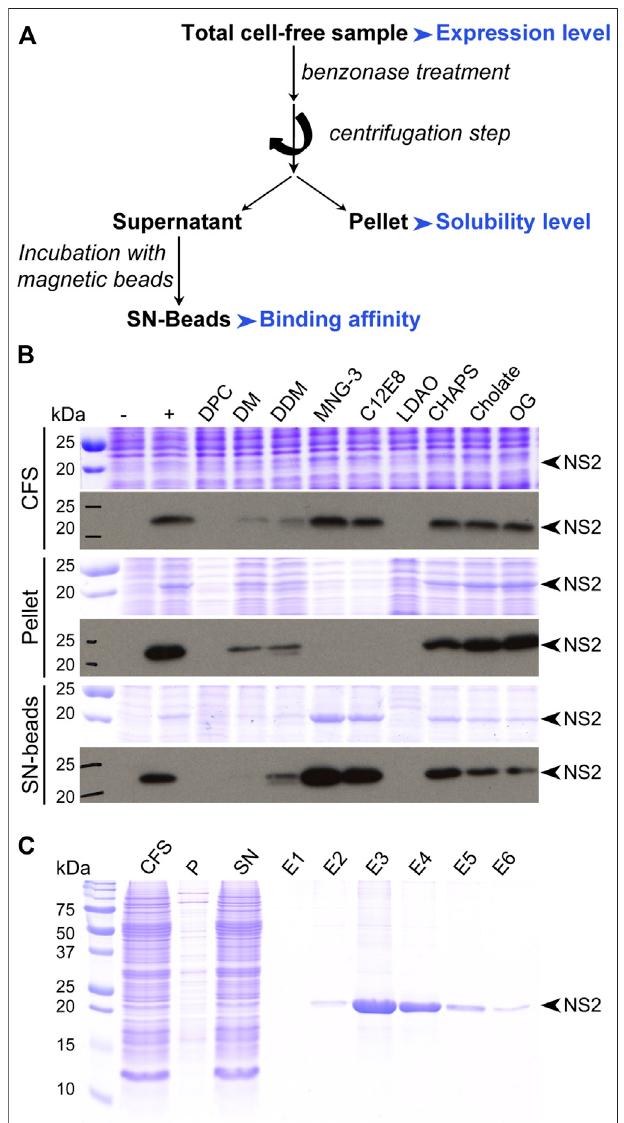
FIGURE 4 | Protein analysis. (A) Typical fl owchart for protein analysis aftersmall-scaleexpression test.Parameterstobeconsideredarehighlighted in blue. (B) Small-scale expression test of the nonstructural protein 2 (NS2) from hepatitis C virus (HCV). This membrane protein was produced in the absence or presence of various detergents at a 0.1% concentration (w/v). Samples were analyzed by SDS-PAGE followed by Coomassie blue staining (upper panels) and Western blotting with an antibody against the Strep-tag II fused at the C-terminus of NS2 (lower panels). CFS, total cell-free sample; pellet, pellet obtained after centrifugation of CFS; SN-beads, supernatant obtained after centrifugation of CFS and incubated with Strep-Tactin magnetic beads to capture Strep-tag II-tagged NS2 protein; − , negative control (no NS2); +, positive control (NS2 expressed in the absence of detergent). The black arrowheads indicate NS2, adapted from Fogeron et al. (2015a). (C) SDS-PAGE analysis followed by Coomassie blue staining of the different steps from the af fi nity puri fi cation of the NS2 membrane protein produced directly in a solubilized form in the presence of MNG-3, adapted from Fogeron et al.